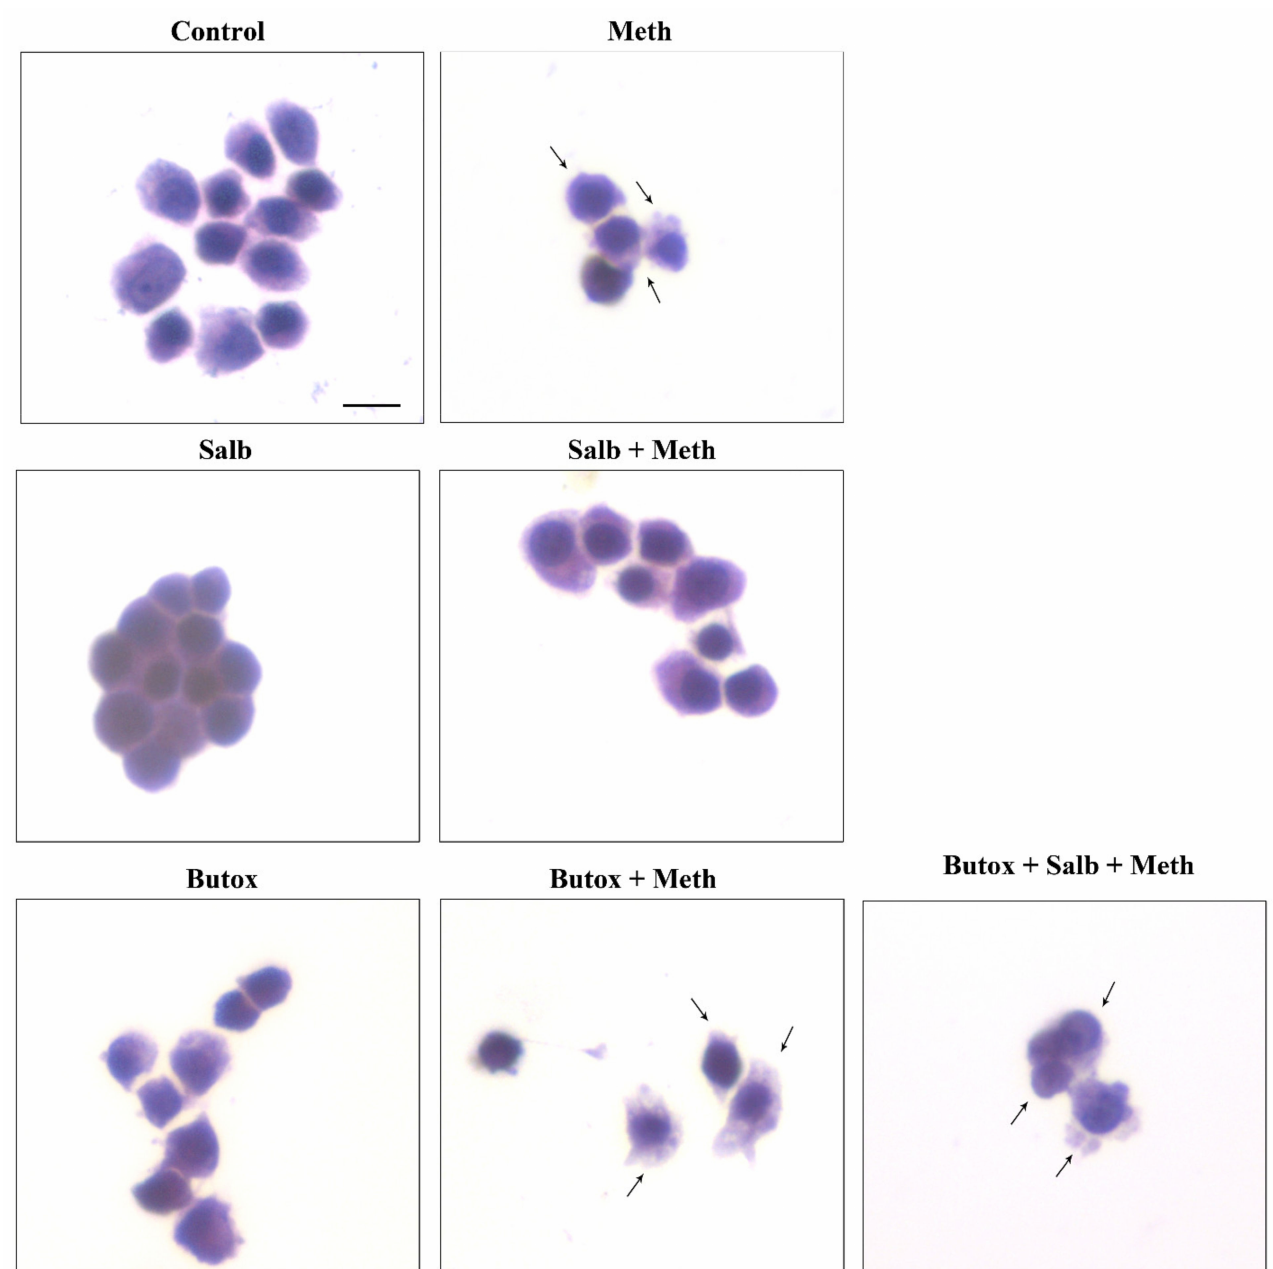
Figure 5. The β 2-AR agonist (salbutamol) protects against Meth toxicity, while the β 2-AR antagonist (butoxamine) impedes such a protection (H&E staining). Representative pictures show that salbutamol (5 µ M) protects against Meth-induced toxicity. This β 2-AR agonist is no longer protecting when the selective β 2-AR antagonist (butoxamine) is administered. Butoxamine alone (10 µ M) does not alter cell viability. Arrows indicate pale eosinophilic cells. Scale bar = 8 µ